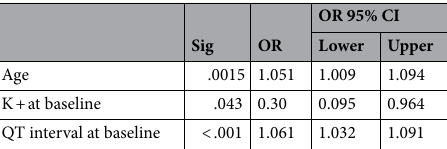
Table 3. Multivariate analysis. CI, confidence interval; OR, odds ratio; Sig, statistical